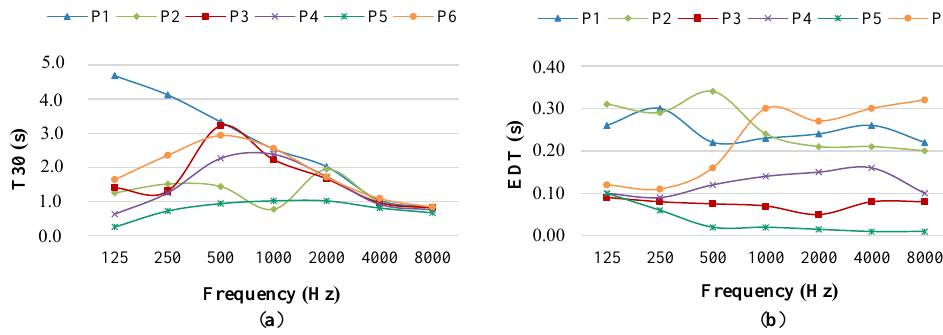
Figure 5. Frequency variation of T30 ( a ) and EDT ( b ) measurements.